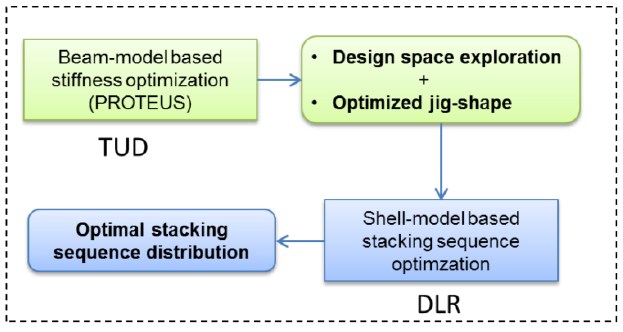
Figure 2. Two-step DLR–TUD aeroelastic tailoring workflow.